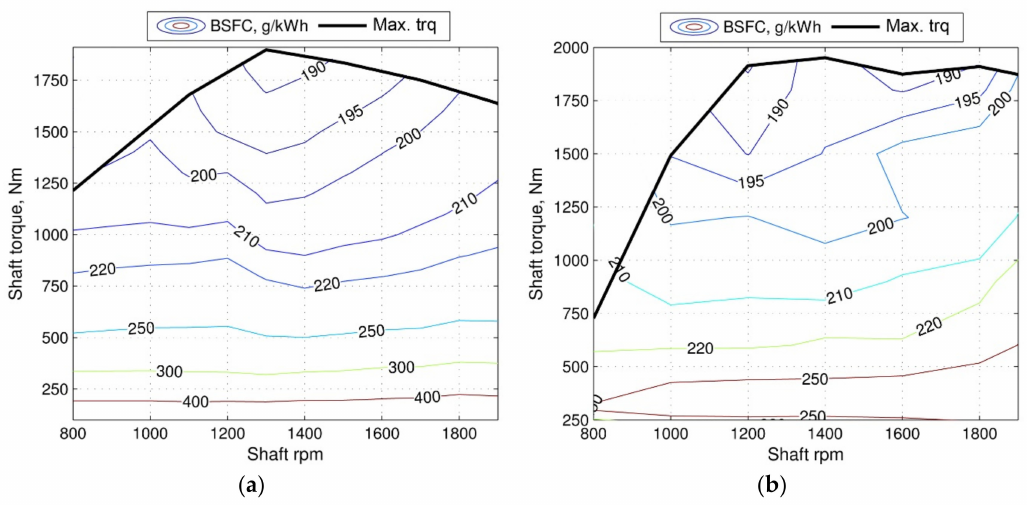
Figure 4. Brake-specific fuel consumption maps of the developed gas engines: ( a ) Otto’s cycle and ( b ) Miller’s